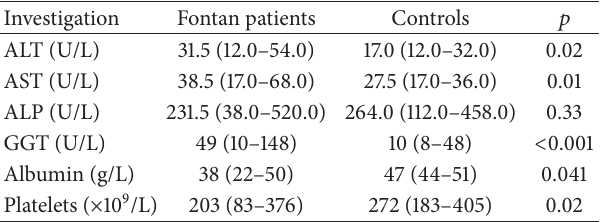
Table 4: Laboratory